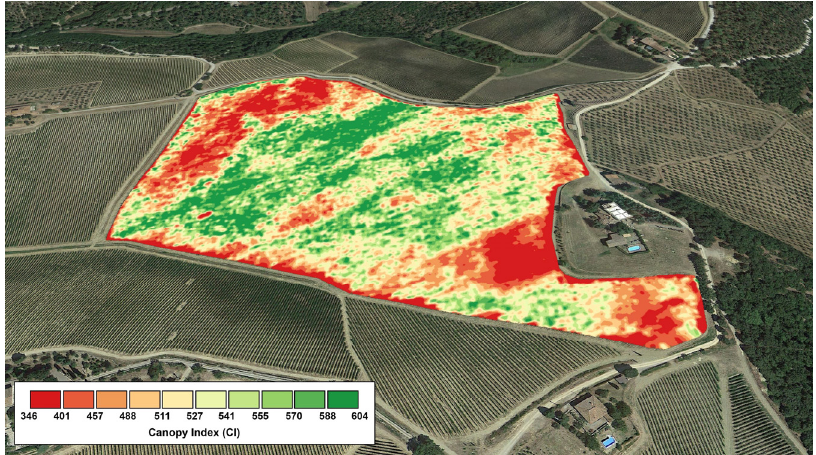
Figure 2. Canopy Index ( CI ) map obtained for a 15 hectare vineyard in Tuscany (Italy).